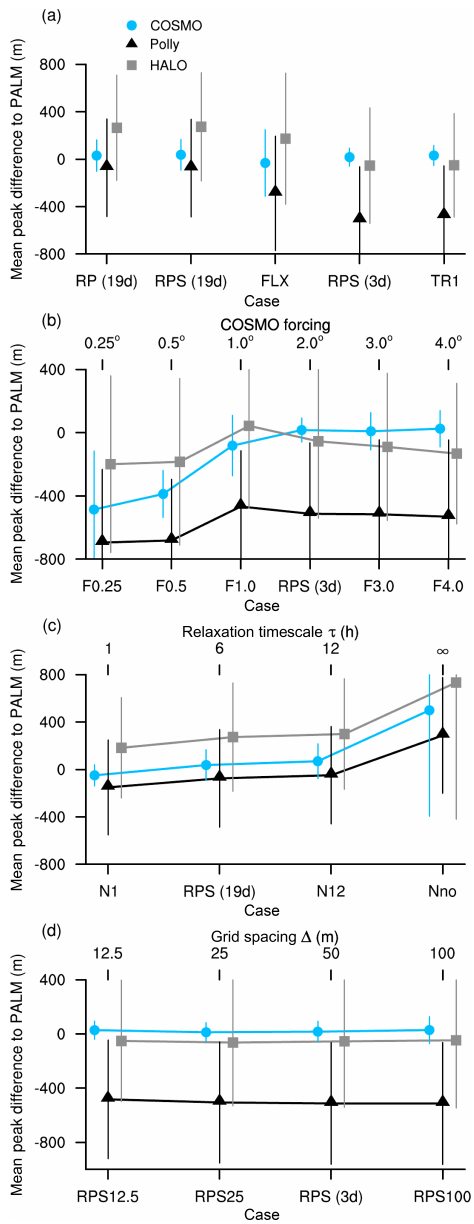
Figure 10. Mean peak difference in boundary layer depth to PALM between 12:00 and 14:00UTC for the simulated cases listed in Table 5. Standard deviations are provided along with the means. Panels (b) – (d) include the mean peak difference for the sensitivity experiments about the averaging size of the COSMO forcing, the nudging timescale and the grid spacing, respectively. Panel (a) lists the remaining cases. Note that the mean peak difference of the PALM reference run on the small domain (RPS) is calculated over the whole 19 days (RPS, 19d) and the 3-day testing period (RPS, 3d). The number of values entering the average are (38, 147 and 464) for 19-day runs and (6, 38 and 78) for 3-day runs. The tuples denote the number of values entering the mean of the difference in boundary layer depth to COSMO, Polly and